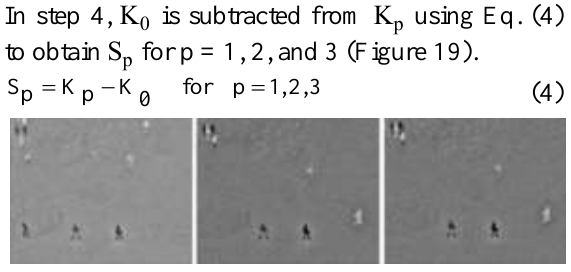
Figure 19. Subtracting K 0 from K p for p = 1, 2, and 3.